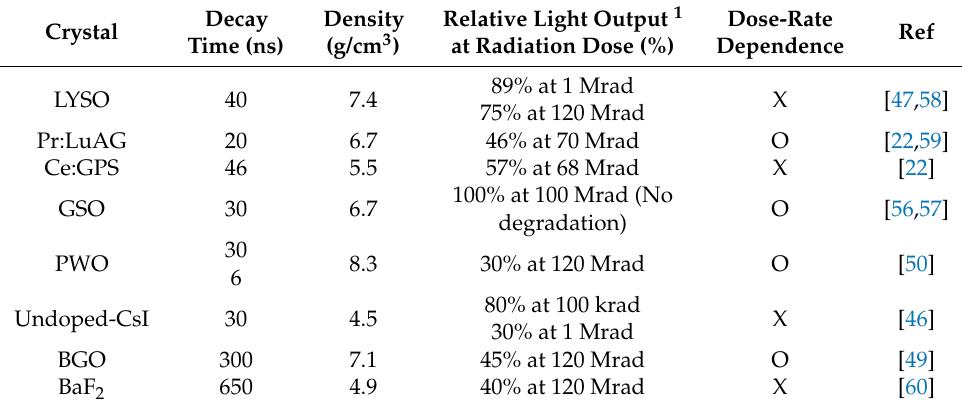
Table 2. Performances of selected scintillators and critical parameters for HEP experiments. Decay Crystal Time (ns)